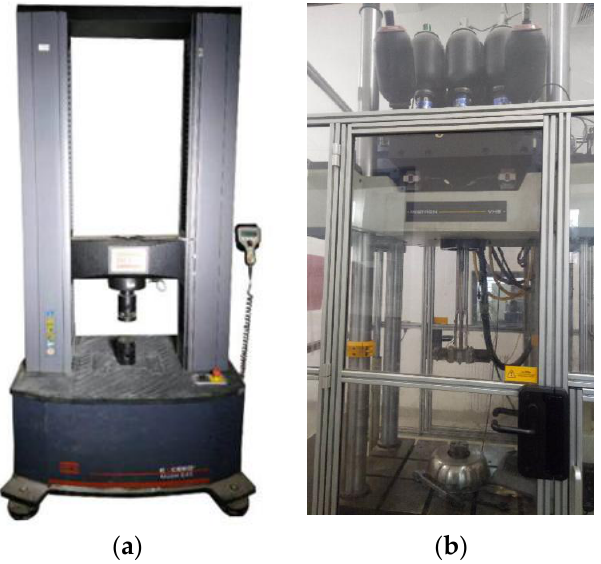
Figure 2. The testing machines used in the present study: ( a ) MTS Exceed E45 testing system; ( b ) INSTRON VHS160/100-20 high-speed testing system.